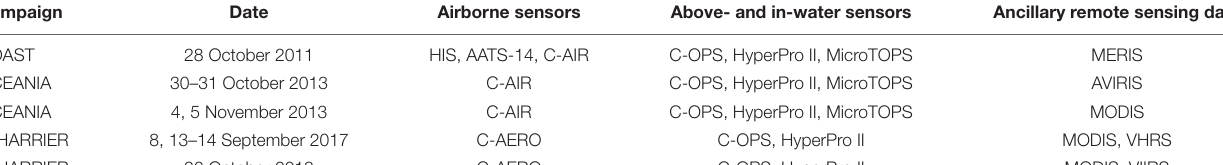
TABLE 1 | Summary of data collection and instrumentation.